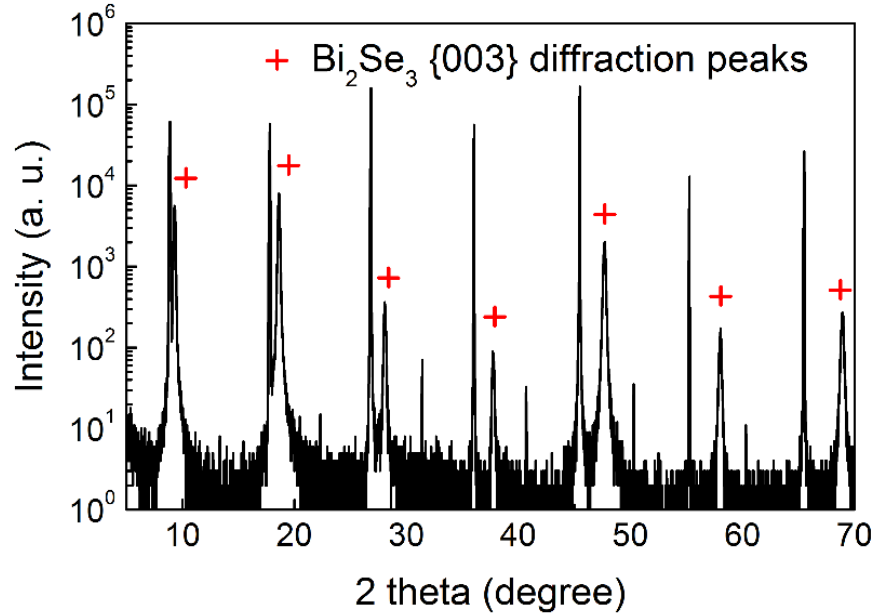
Figure 4. XRD di ff raction pattern of Bi 2 Se 3 on mica with bu ff er layer. The Bi 2 Se 3 {003} family of planes Figure 4. XRD diffraction pattern of Bi 2 Se 3 on mica with buffer layer. The Bi 2 Se 3 {003} family of planes are labeled by red crosses, while other peaks originate from the mica are labeled by red crosses, while other peaks originate from the mica substrate.